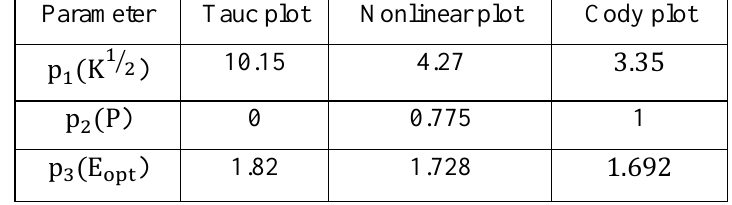
Table 1: Linear and nonlinear regression results and Cody plot of a-Si: H films.